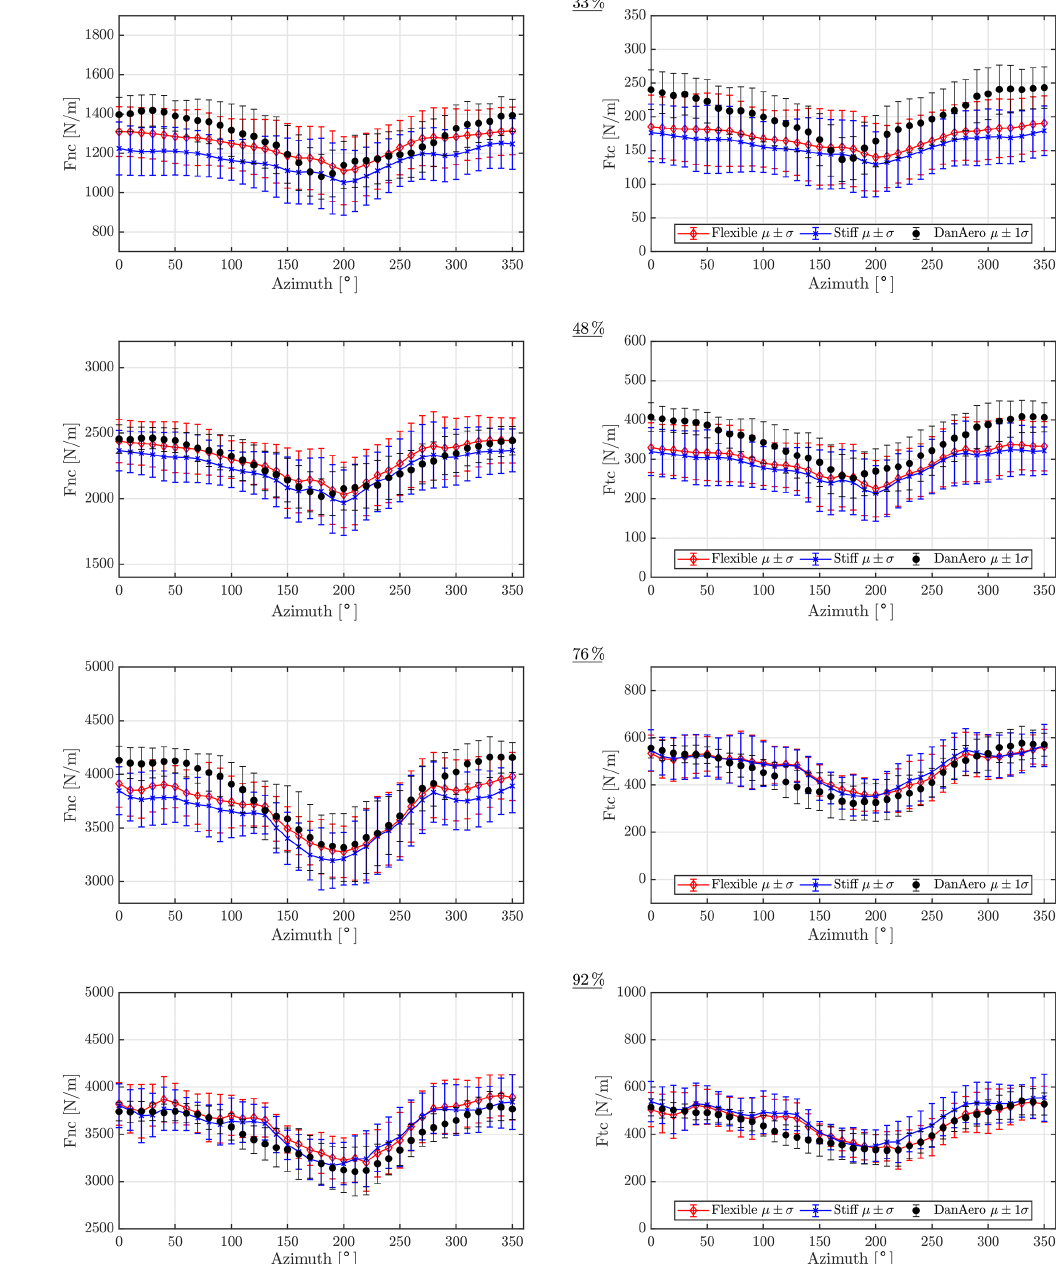
Figure 16. Normal and tangential forces for stiff and flexible simulations along with DanAero measurements. Sections at 33, 48, 76, and 92% blade